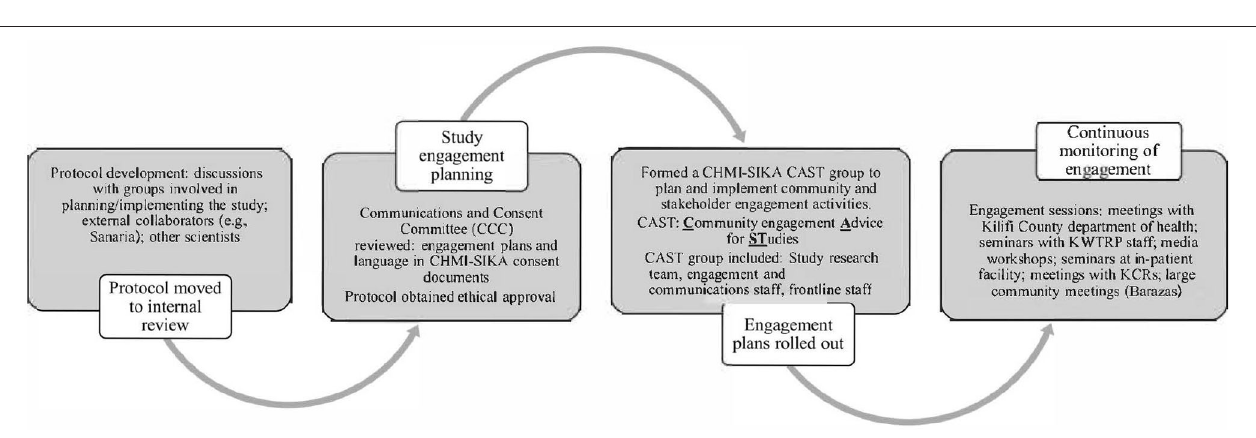
FIGURE 2 | Flow diagram depicting how engagement planning was done for the CHMI–SIKA